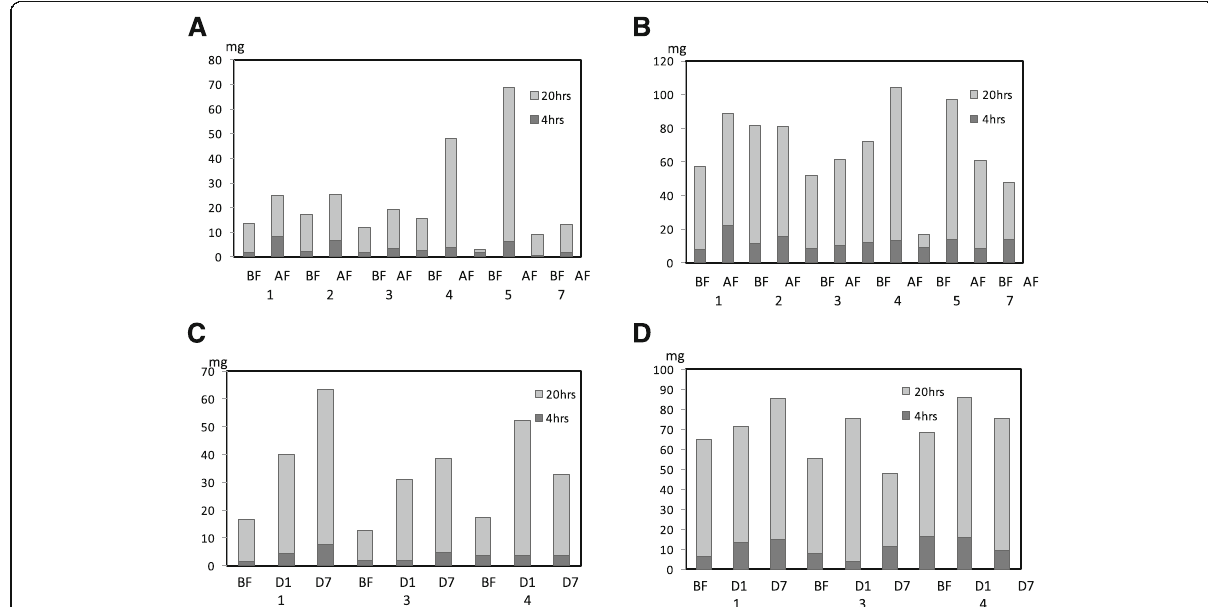
Fig. 6 Changes in urinary free and total aceneuramic acid (Trial-2). Urine was collected in periods of − 24 to 20 h and - 20 to 0 h (before administration), 0 to 4 h and 4 to 24 h (after administration). Both free and total aceneuramic acid concentration in urine were measured. The amount of urinary excretion was calculated from urine concentration and its volume. The amount of free aceneuramic acid excretion in 24 h increased after administration. Also the amount of total aceneuramic acid excretion in 24 h roughly increased. a . Free aceneuramic acid